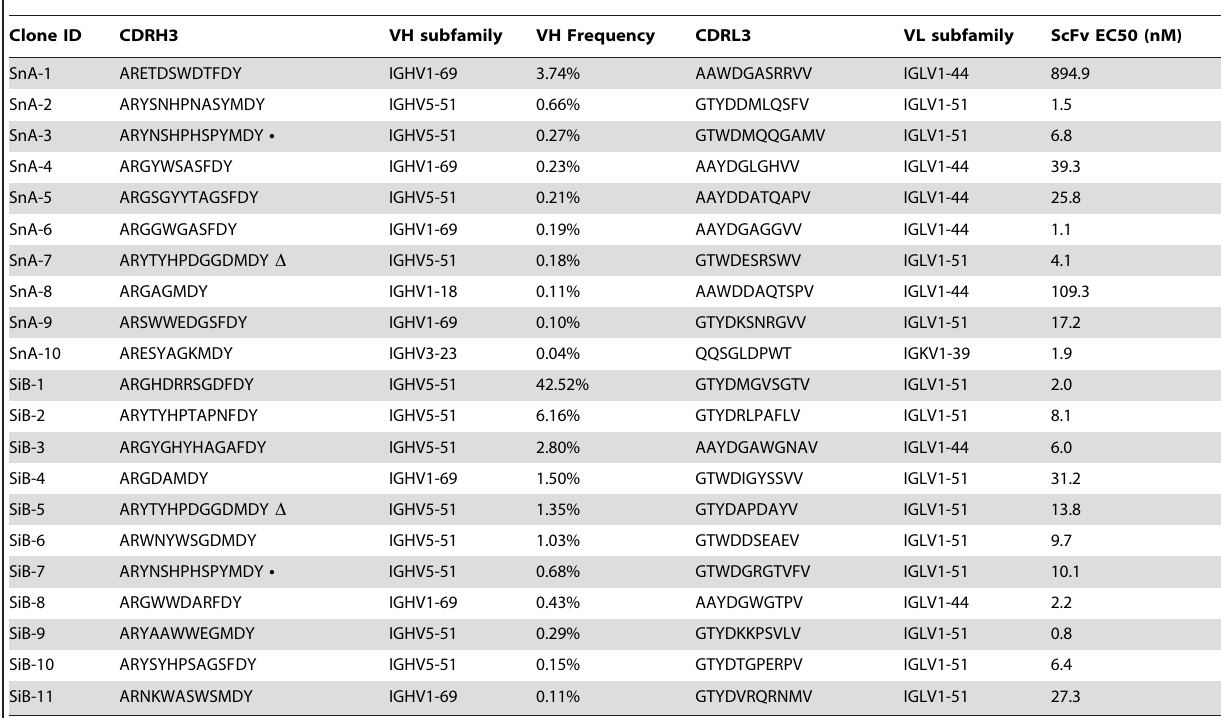
Table 3. Frequency and potency of binders derived from synthetic